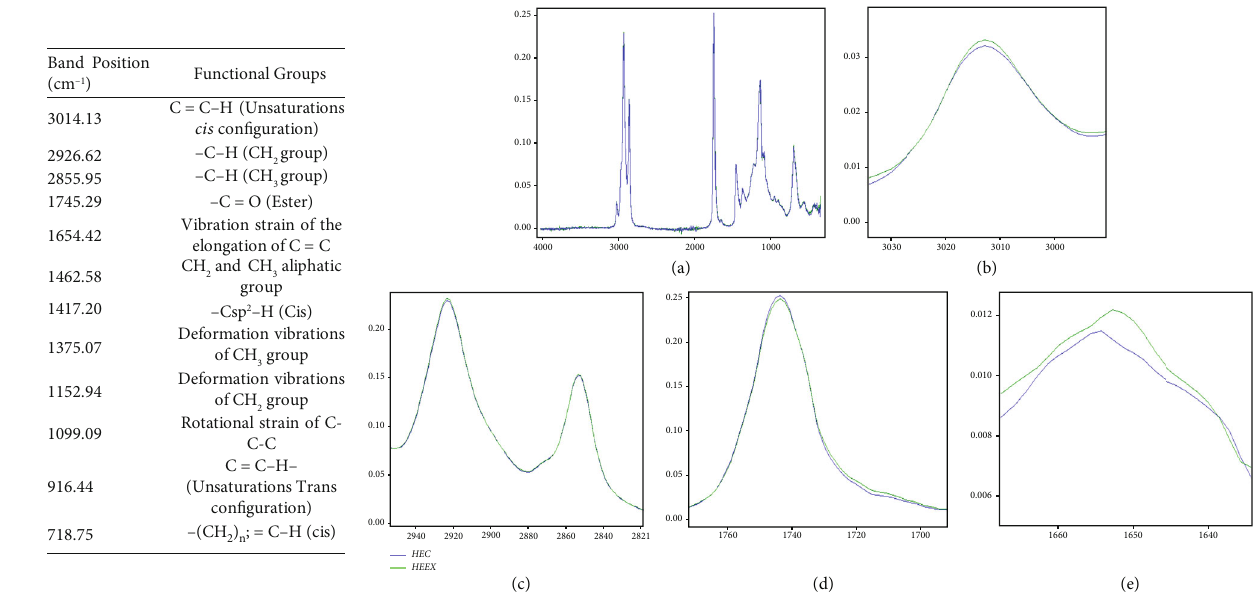
Figure 1: FTIR pro fi le of Fontitrygon margarita liver oils according to the extraction method. (a) General shape of the curves between 4000 and 500cm -1 . (b) Region curves between 3040 and 2900 cm -1 . (c) Region curves between 2953 and 2820 cm -1 . (d) Region curves between 1772 and 1774cm -1 . (e) Region curves between 1667 and 1661cm -1 ; HEC: oil extracted by cooking-pressing; HEEX: oil extracted by